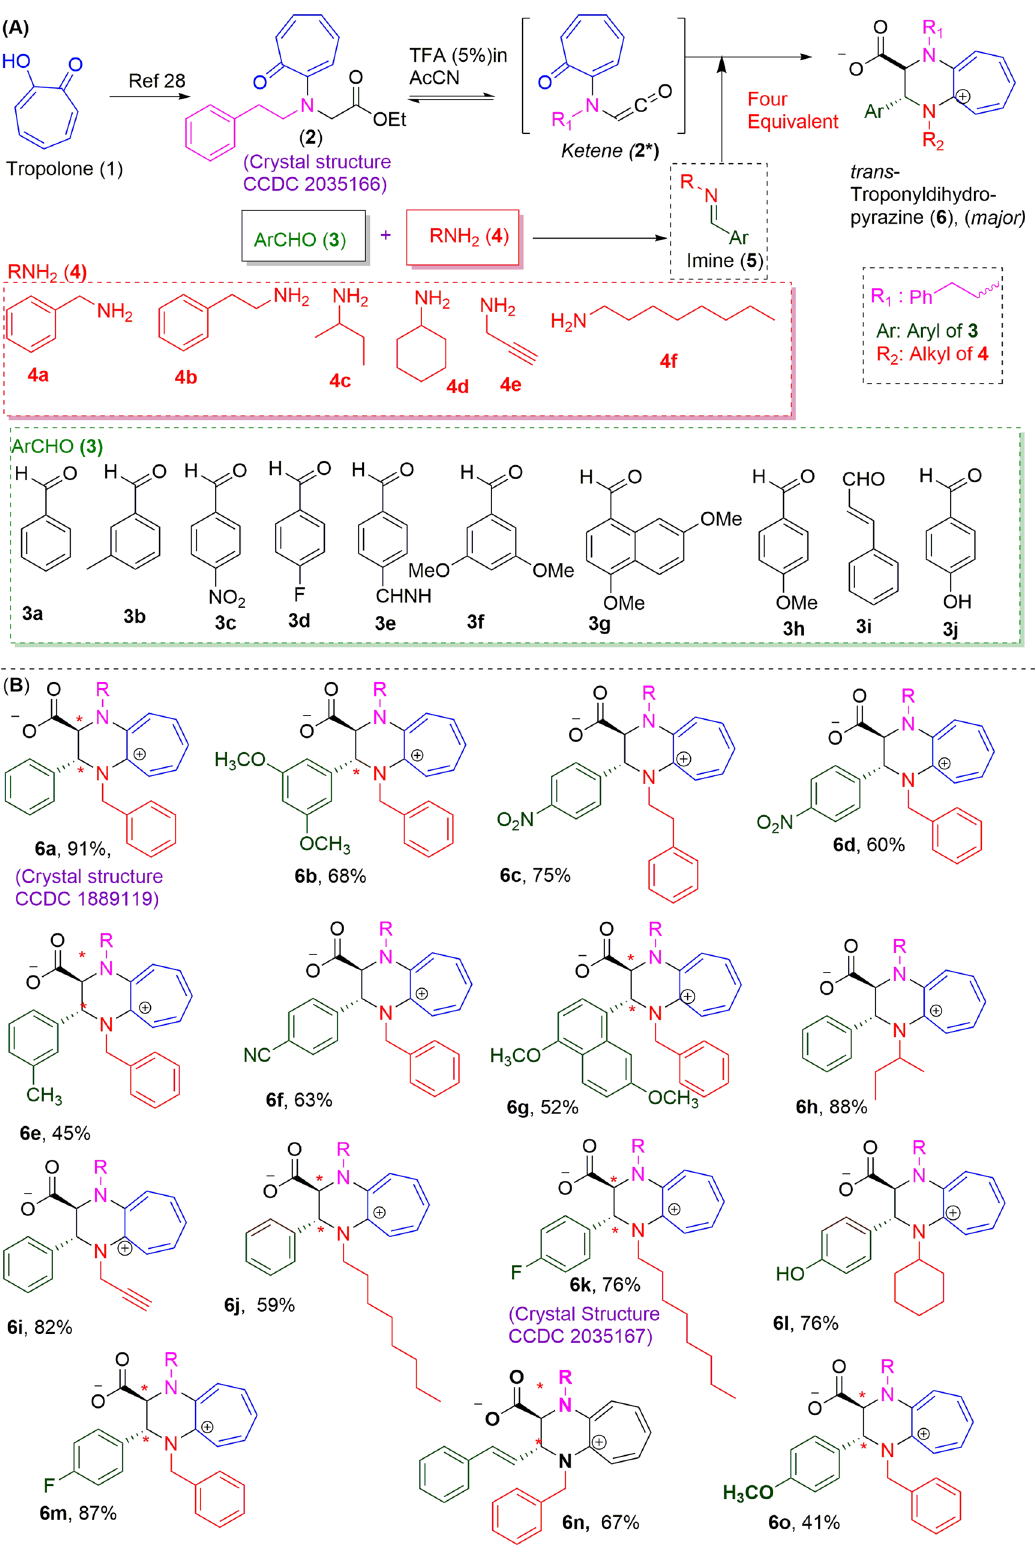
Fig. 2 Chemical synthesis of cATC derivatives from tropolone and imines. A Formation of Ketene intermediate that reacts with imine and form cATC derivative. B Structure of various cATC derivative from different